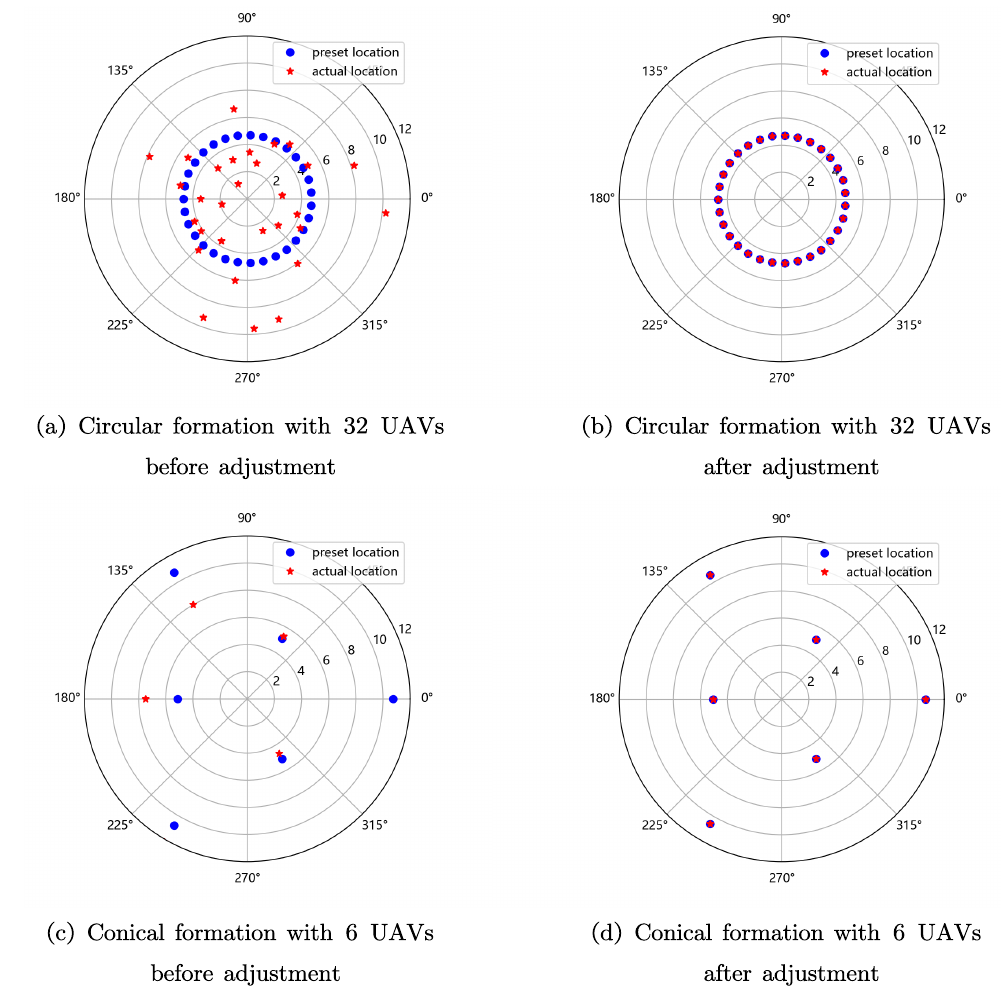
Figure 5. Schematic diagram for the